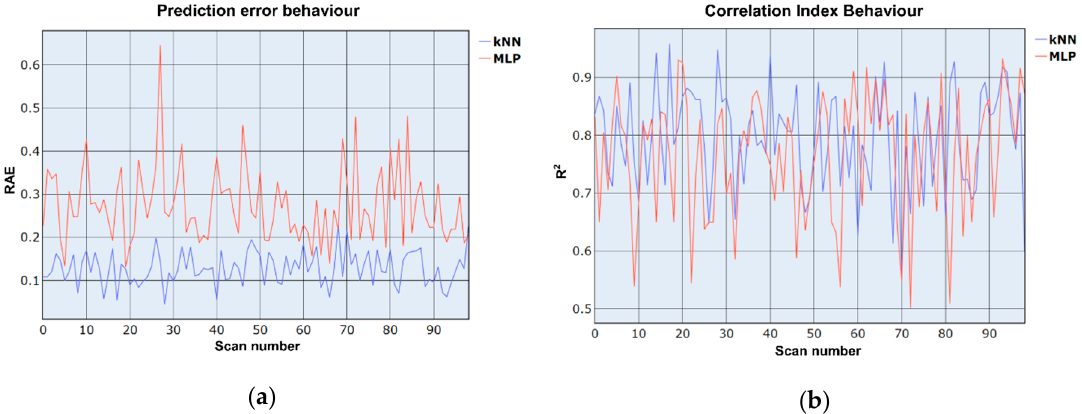
Figure 9. Behavior representation of both reliability models. ( a ) Prediction error behavior, RAE, and ( b ) correlation index behavior, R 2 .